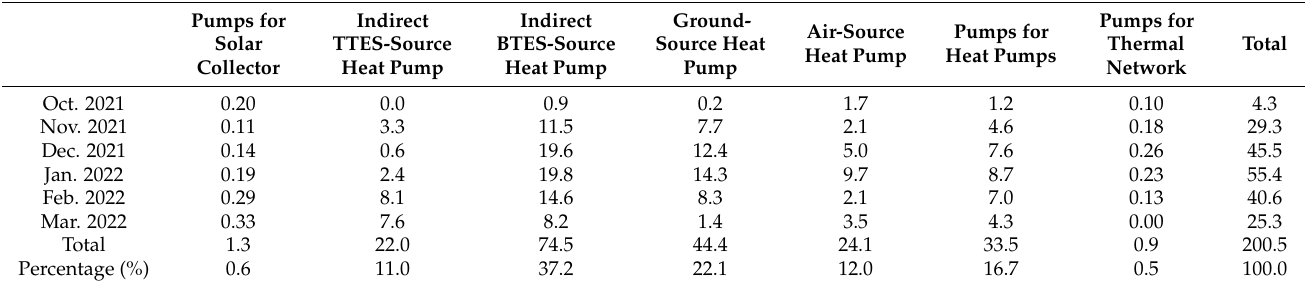
Table 5. Monthly electric energy consumption of the system